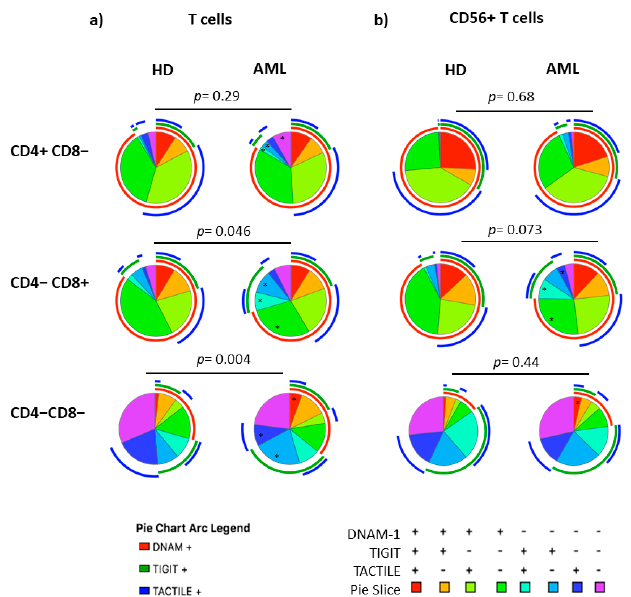
Figure 5. Co-expression patterns (pie charts) of DNAM-1, TIGIT and TACTILE in CD4+, CD8+ and DN T cell subsets distributed according to CD56 expression: conventional CD56 − T ( a ) and CD56+ NKT-like ( b ) cells from HD ( n = 20) and AML patients ( n = 23). The asterisk (*) within the slices refers to statistically significant differences between AML patients and healthy donors for the indicated subsets ( p < 0.05). HD: healthy donors, AML: acute myeloid leukemia patients.